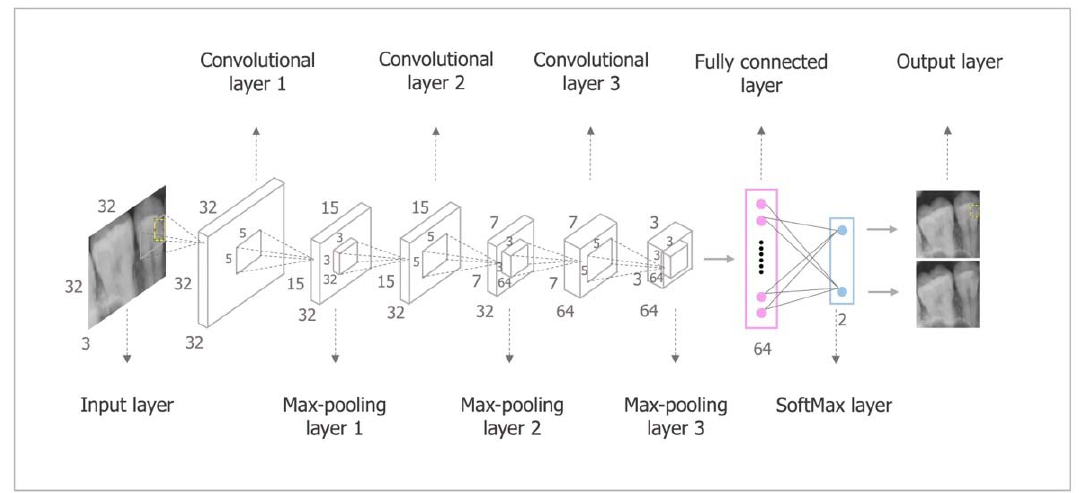
Figure 2. The workflow process of the CNN.